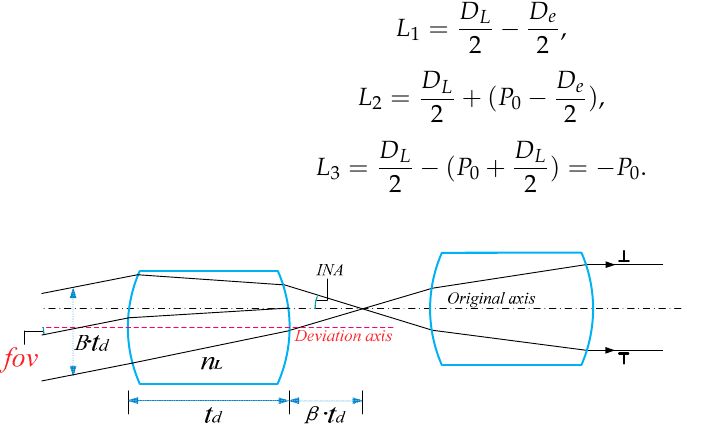
Figure 5. Schematic of MLA system